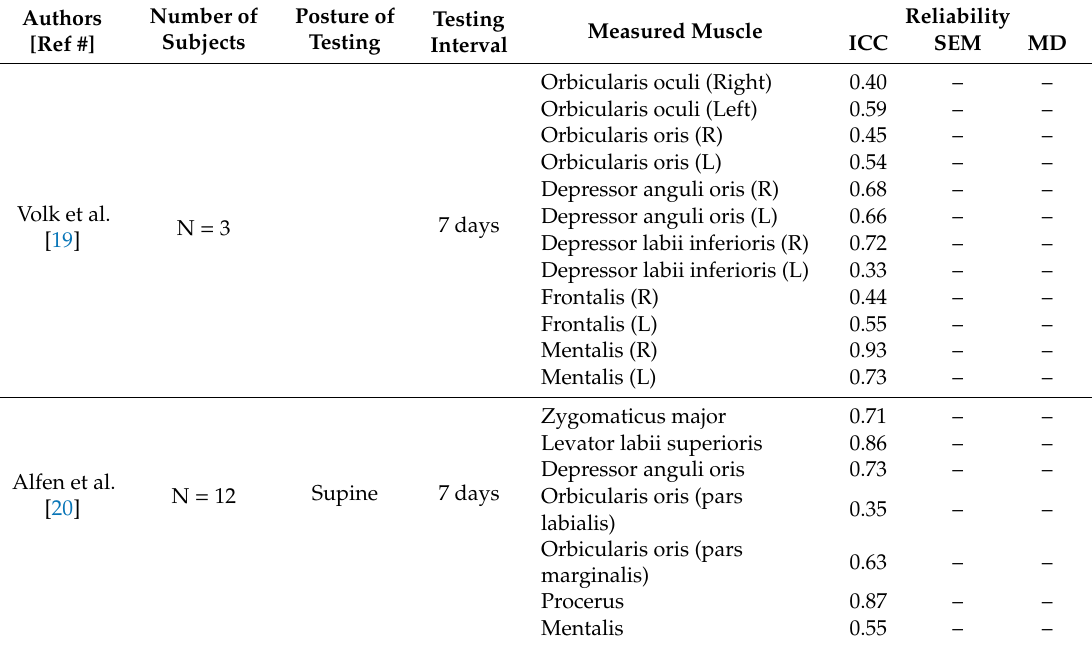
Table 3. Intra-rater reliability of ultrasound measurements of facial muscle